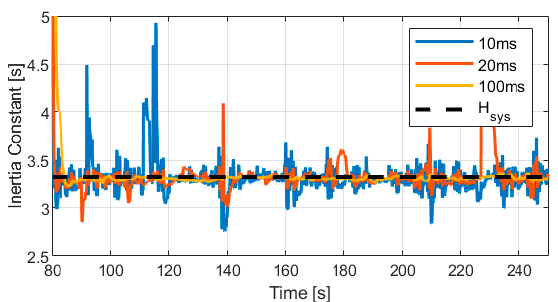
Figure 4 . The trajectory of the estimated inertia during normal operation for different measurement time resolutions.